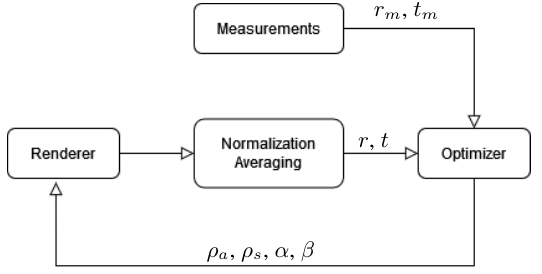
Figure 2. Simulation flow for a single wavelength: optimizer compares measured reflection and transmission to the values produced by Blender and adjusts leaf material parameters accordingly. Modeled reflection and transmission values are normalized with virtual white reference sample and averaged over all pixels in the rendered image.